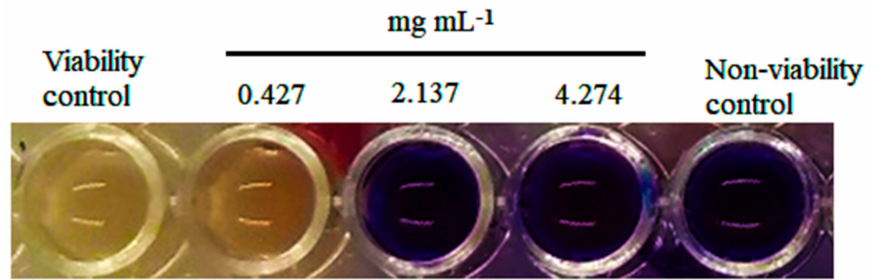
Figure 1. Minimum inhibitory concentration for TvEO on hyphal discs from Clonostachys rosea obtained by the broth microdilution method using resazurin as an indicator of cell